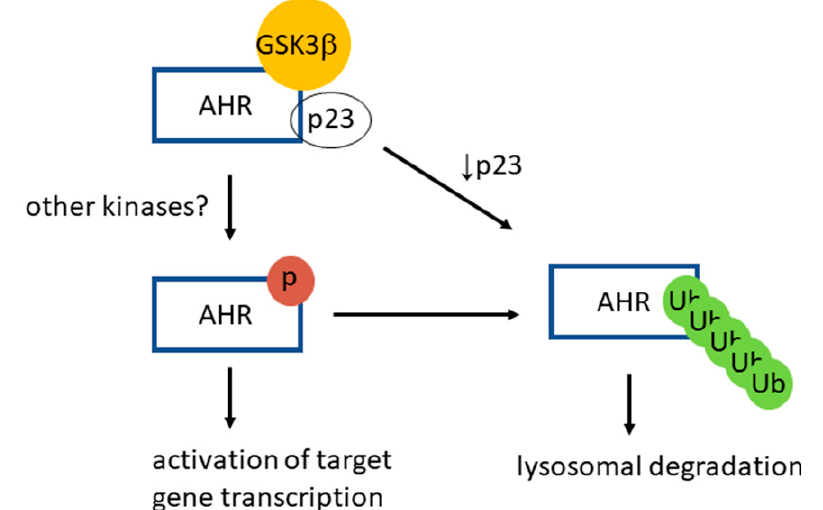
Figure 9. A proposed model of GSK3 β role on AHR function and degradation. AHR is phosphorylated by GSK3 β in a p23-dependent manner in HeLa cells. This phosphorylation is required for optimal activation of the ligand-dependent AHR target gene transcription. After phosphorylation, AHR is K63-ubiquitinated and is targeted for the LC3-mediated selective autophagy. When the p23 content is compromised in HeLa cells, AHR is more prone to degradation via autophagy, bypassing the GSK3 β phosphorylation of AHR.